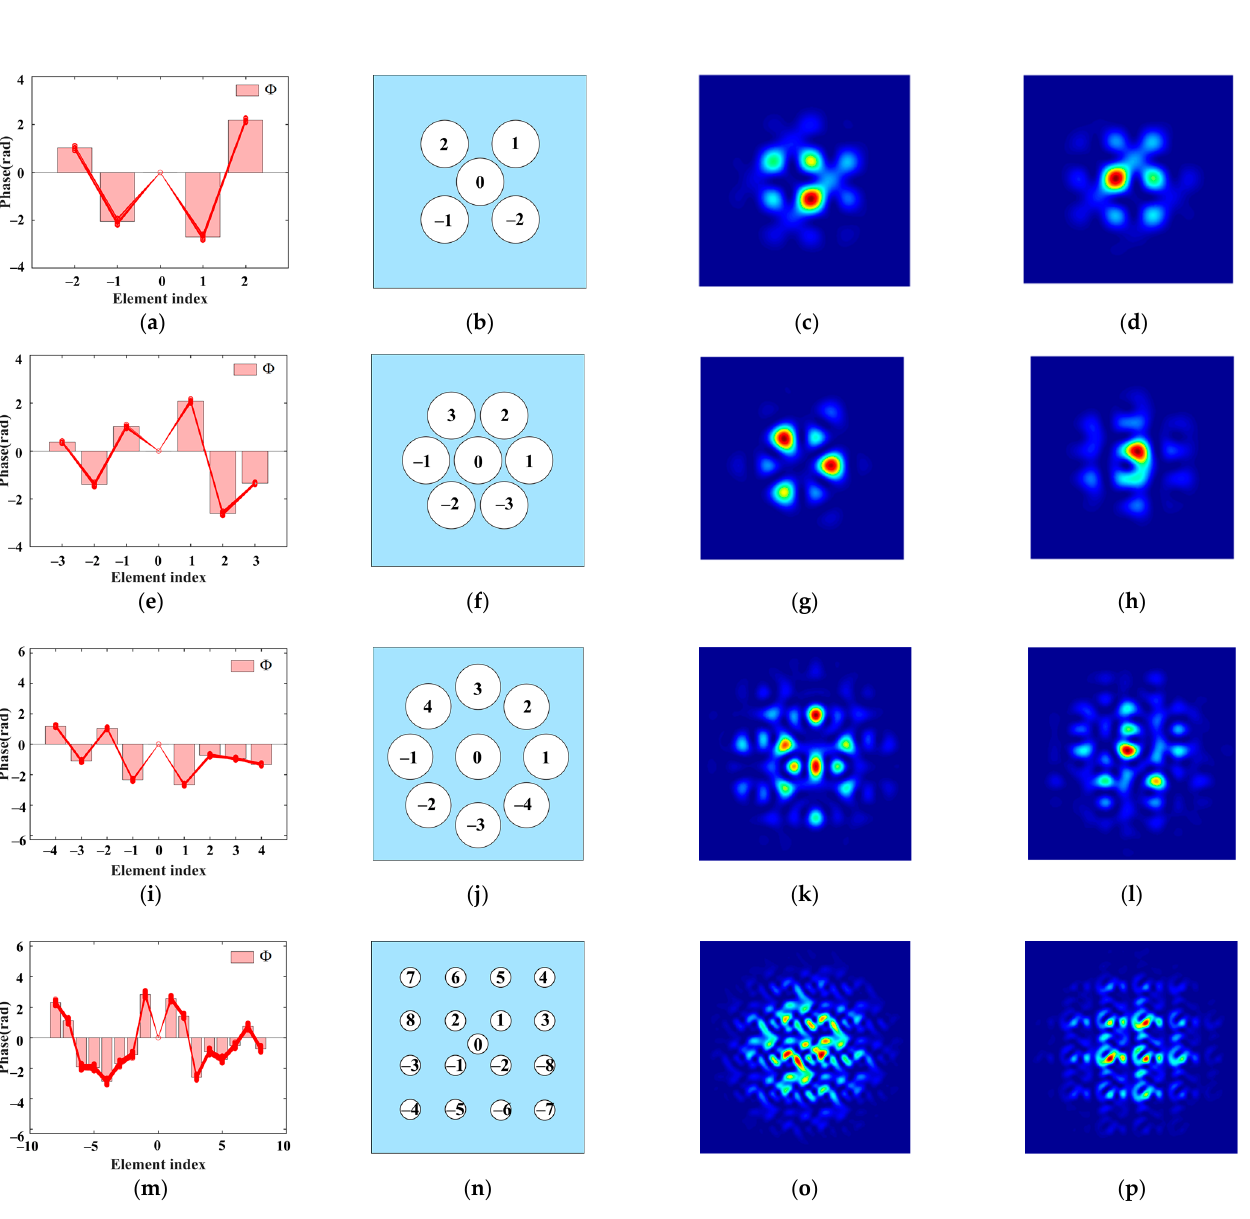
Figure 7. ( a ) In the process, we not only make Θ generate the samiliar far-field to Φ , but also make modulated Θ generate the samiliar far-field to modulated Φ ; ( b ) The modulation phase we use in the 5-element system; ( c ) The modulation phase we use in the 7-element system; ( d ) The modulation phase we use in the 9-element system; ( e ) The modulation phase we use in the 17-ele- ment system.